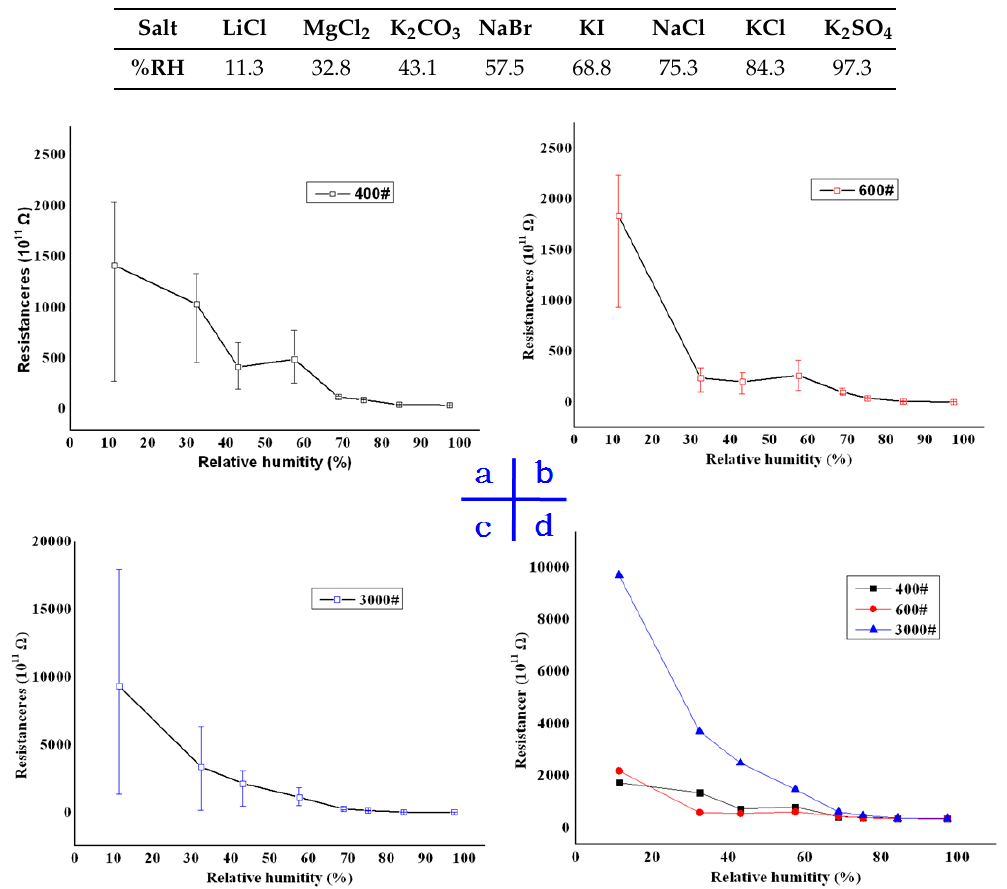
Table 1. The saturated salt solution and relative humidity (RH).